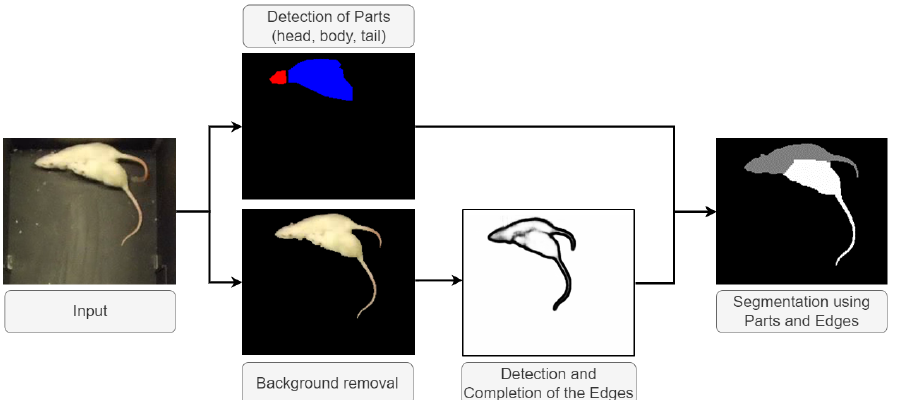
Figure 5. Sketch of the test pipeline for a single frame. Our aim is to maximize the segmentation precision within the frame to provide a strong basis for tracking. Body parts and edges are predicted and edge completion methods are invoked. A pre-processing provides the foreground masks and removes the background from the frame. A post-processing module combines the information and predicts the segmentation of the instances separately to enable identity tracking. Note the error in the last subfigure: the head of one of the animals is mislabeled. However, tracking remains